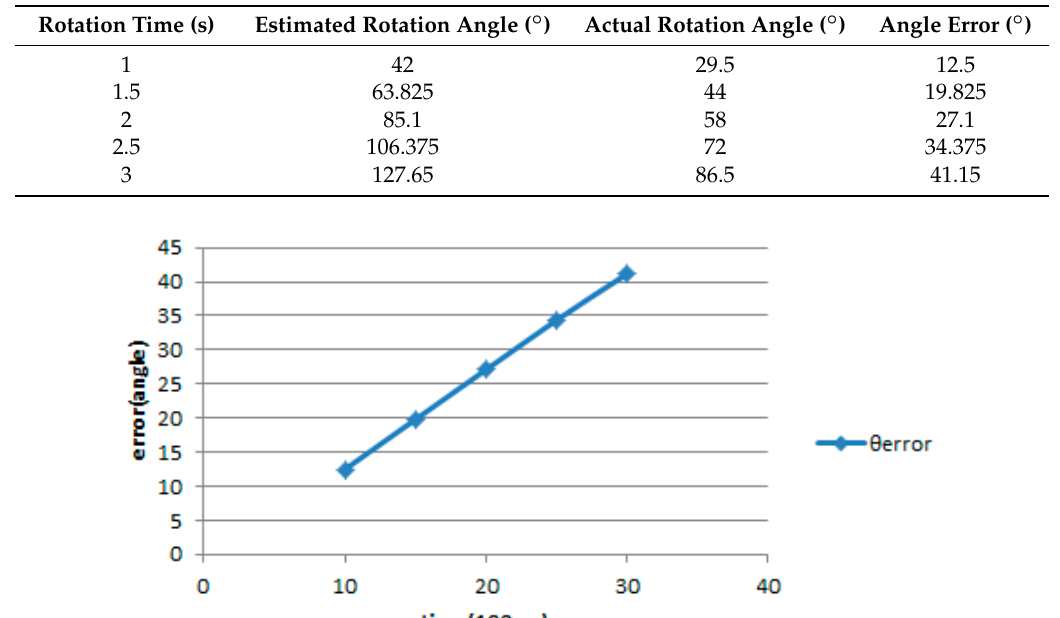
Table 5. Rotation angle calculation—general estimation method.